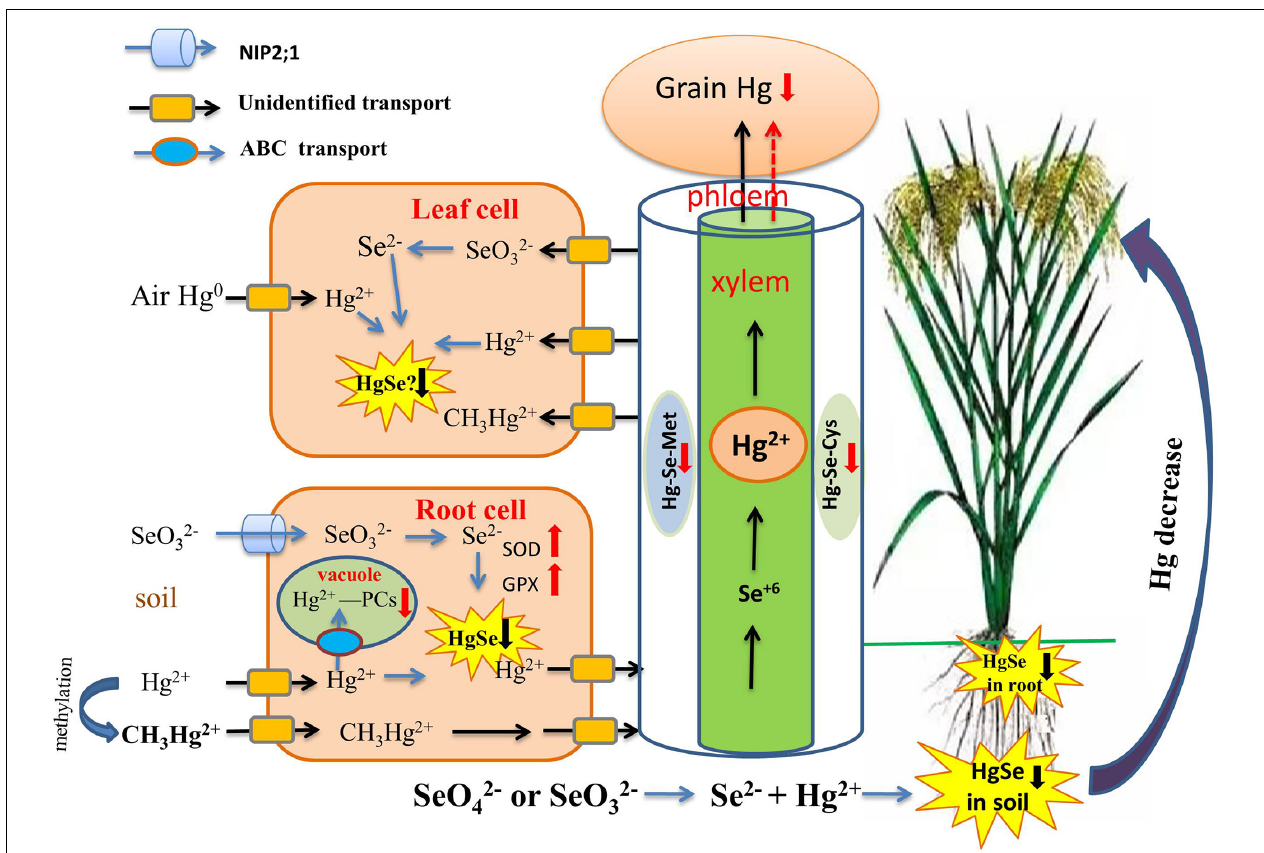
FIGURE 3 | Overview of the role of Se in regulating Hg bioavailability and accumulation. Se reduces Hg transport from the root to the shoot, and then to the grain through the formation of insoluble HgSe in soil, roots, and possibly leaves (black down arrow). Then Hg-PCs complexes are sequestered in vacuoles and phloem, which are restricted in their upward Hg migration (red down arrow). Se reduces Hg uptake by plants by elevating the activities of SOD, POD, CST, GSH-Px, and GPX (red up